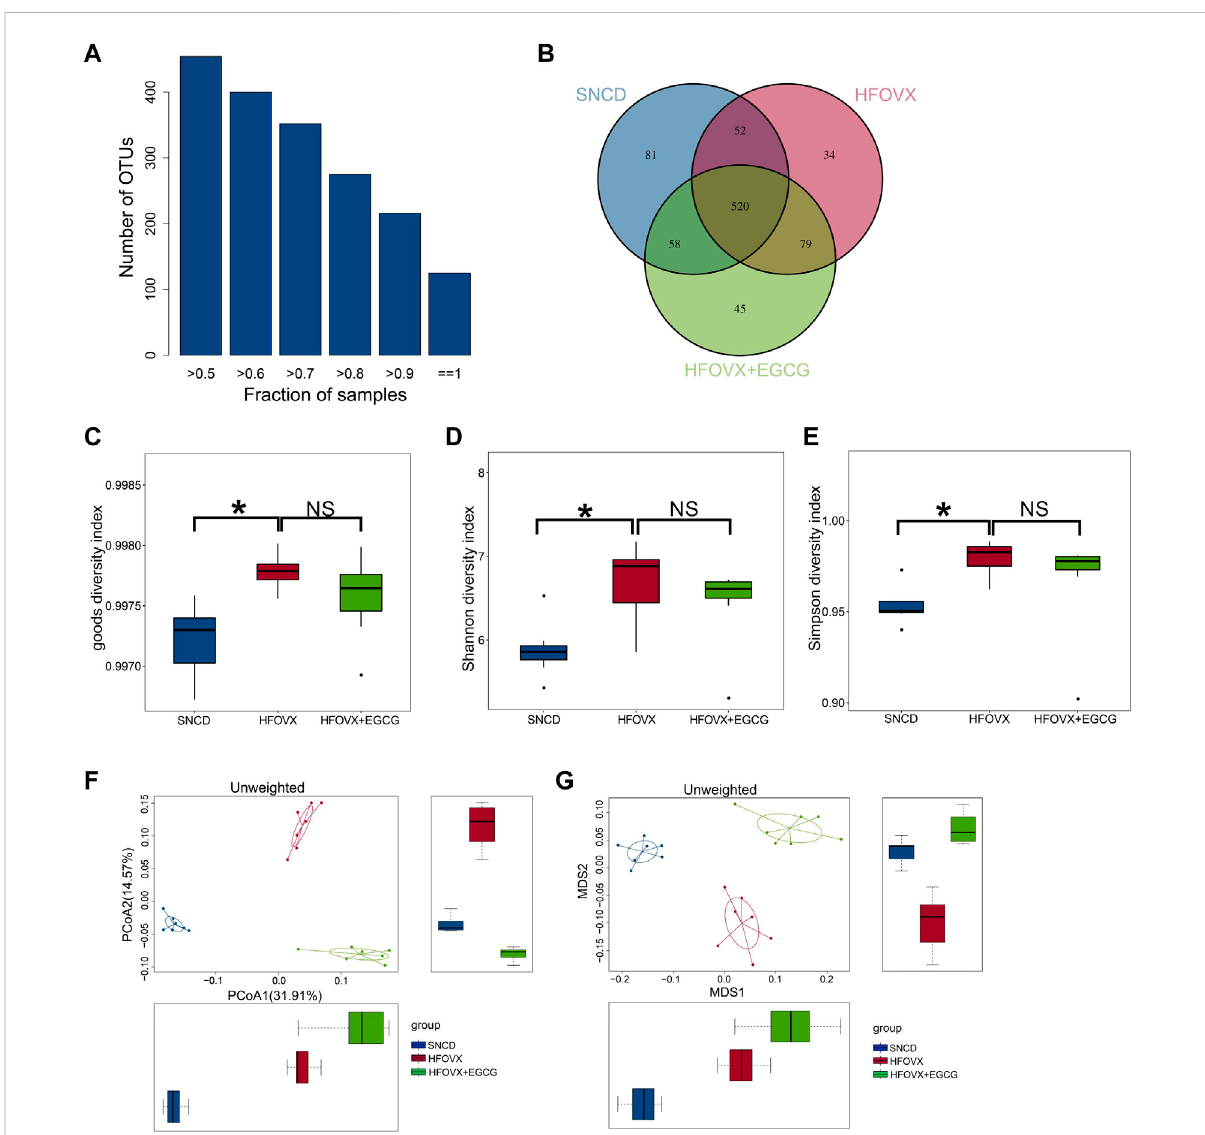
FIGURE 2 PrincipalcomponentanalysisofOTUsforgutmicrobiota withdifferenttreatments. (A) RelationshipbetweenthetotalOTUnumberandsample number. The x-coordinateis theproportion ofthecovered samples, and they-coordinate isthenumberofOTUs for which coverageisgreater than the sample proportion. (B) OTUs on a Venn diagram with different color graphics representing different samples (groups); the overlapping region of different colors is the number of OTUs common across samples (groups). Blue represents the OTU number of the SNCD mice; red represents the OTU number of the HFOVX mice; green represents the OTU number of the HFOVX+45 mg/kg EGCG mice; n = 7 mice. (C – E) Goods coverage (C) , Shannon (D) , and Simpson (E) diversity indexes. The abscissa represents the sample groups, and the ordinate represents the goods coverage, Shannon, and Simpson index values for the different groups. * p < 0.05, HFOVX group vs. SNCD group; n = 7 mice. NS: no statistical signi fi cance. (F – G) Unweighted principal coordinates analysis (PCoA) (F) and non-metric multidimensional scaling (NMDS) (G) based on the distance matrix of UniFrac dissimilarity of the gut microbial communities in mice. Each point represents one sample, and each group is denoted by a different color. Circles combine samples from the same group by their respective 95% con fi dence interval ellipses; n = 7